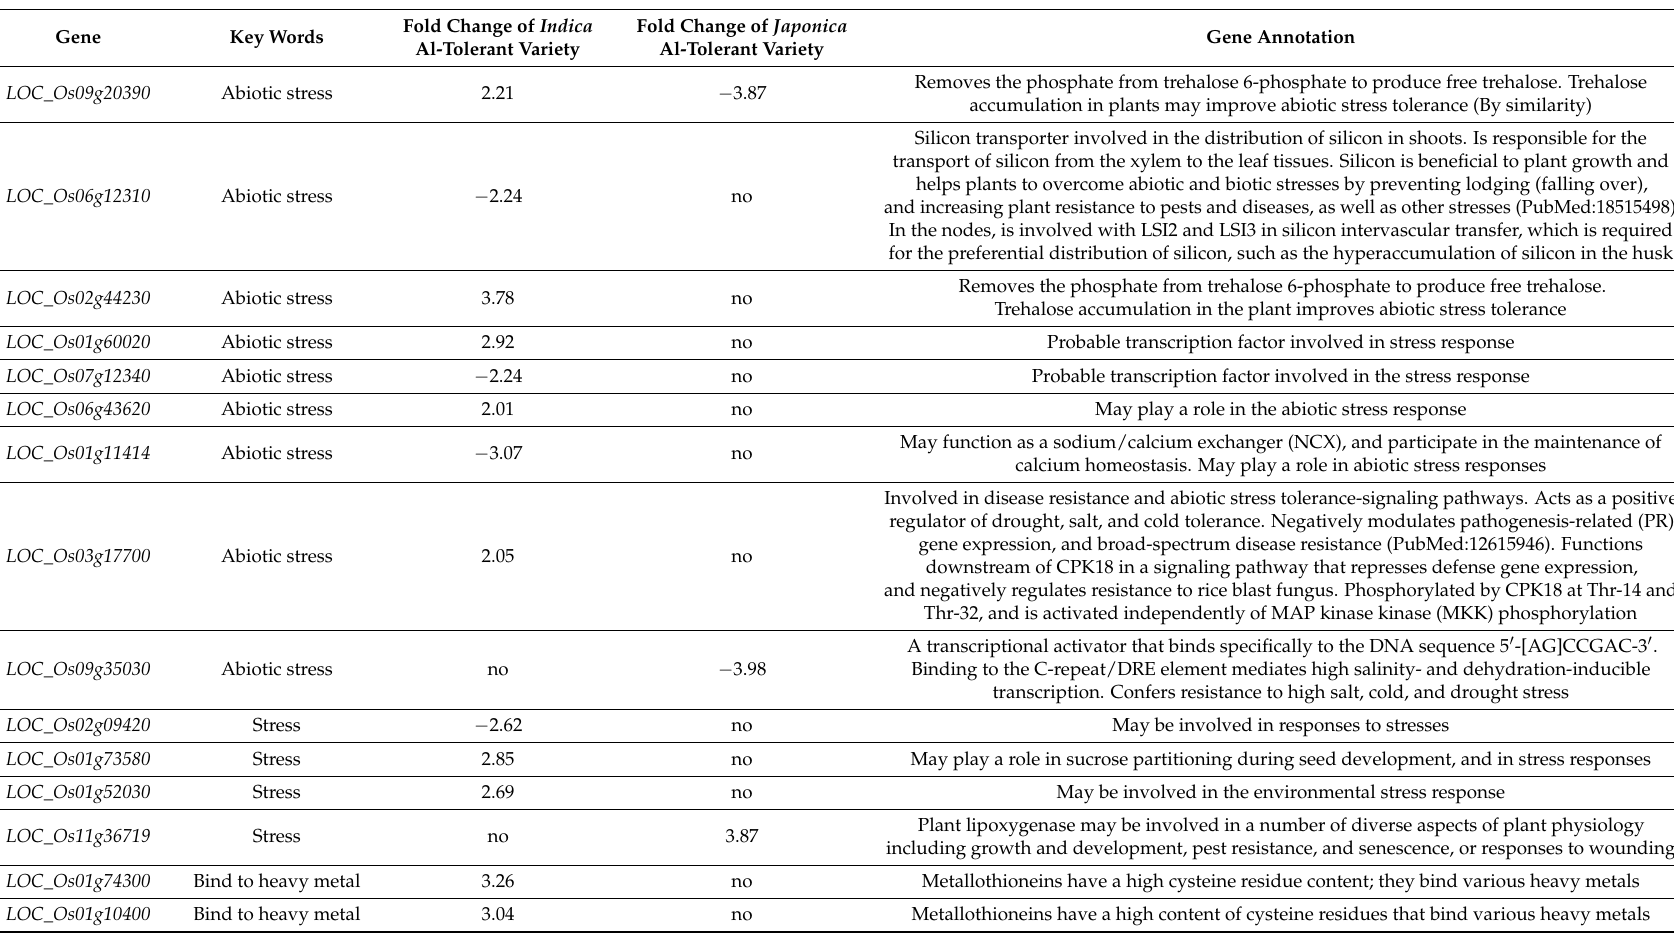
Table 3. Putative candidate genes that are differentially expressed between Indica and Japonica after Al toxicity treatment.